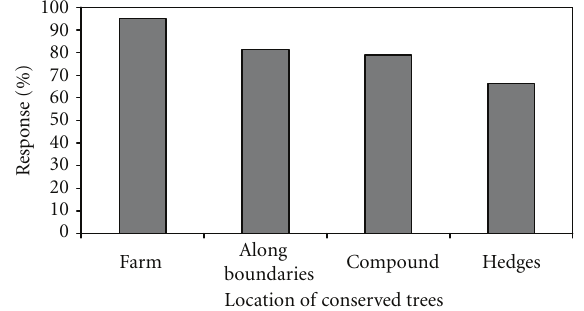
Figure 2: Management niches of shea trees by farm households in Amuria district, eastern Uganda.